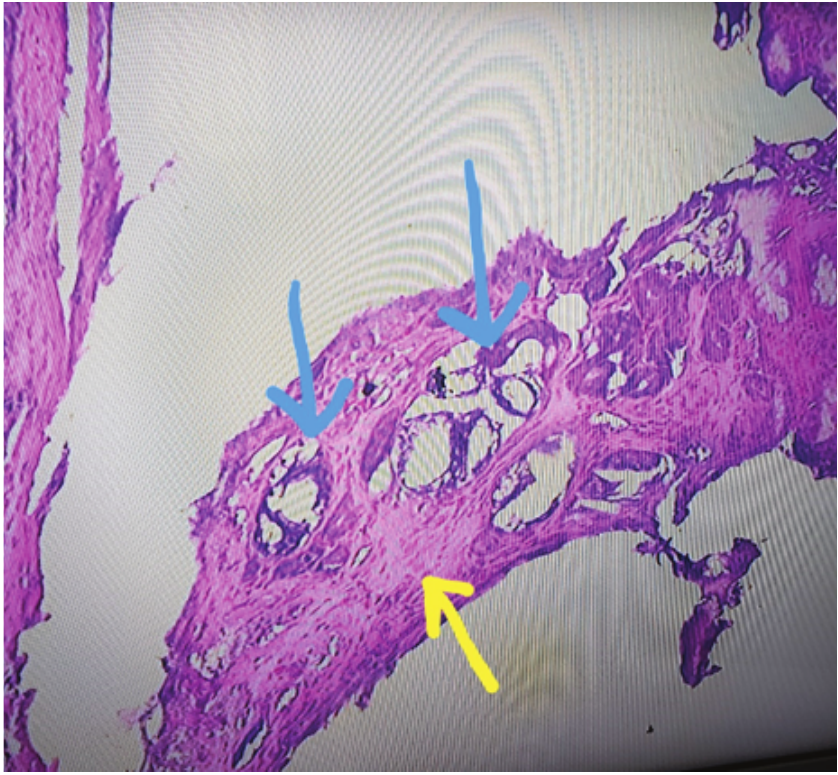
Figure 2: Nests of Brunner glands (blue arrow) that are separated by smooth muscle bundles (yellow arrow).